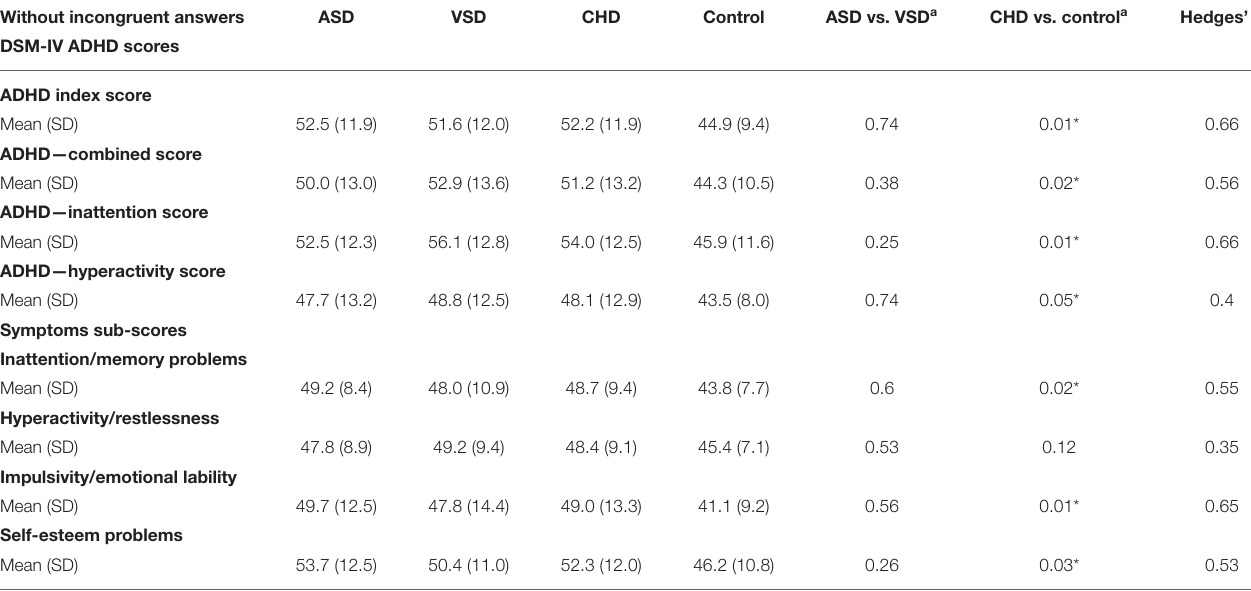
TABLE 5 | Mean and SD between groups of T-scores (when participants with incongruent answers are excluded). Without incongruent answers CHD vs. control a Hedges’ g